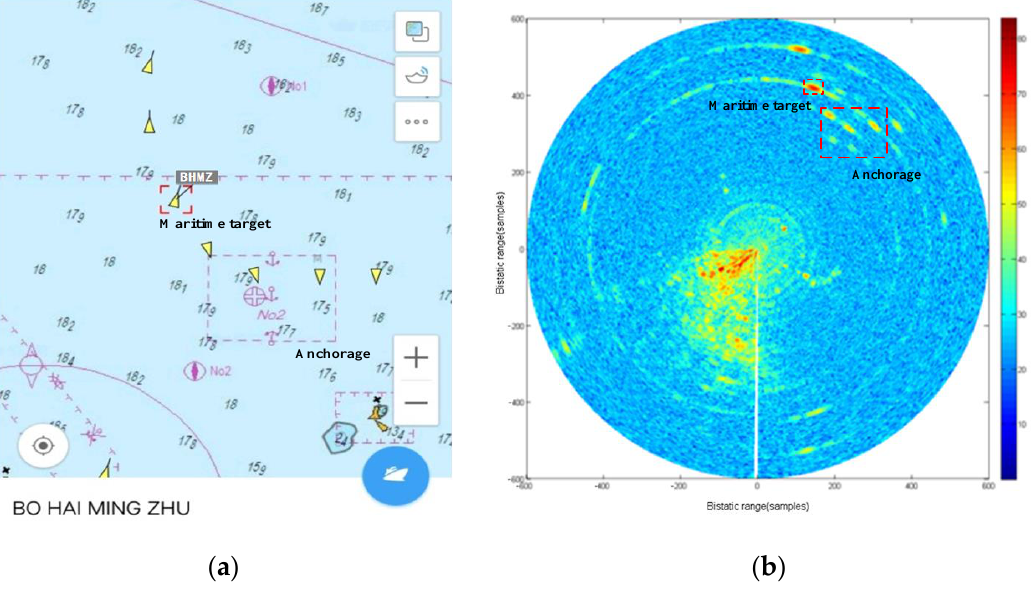
Figure 17. Comparison of the results between the AIS map and HBR map of maritime targets (T1 time: 10:32:13, range: 29.25 km): ( a )AIS map; ( b ) HBR map.